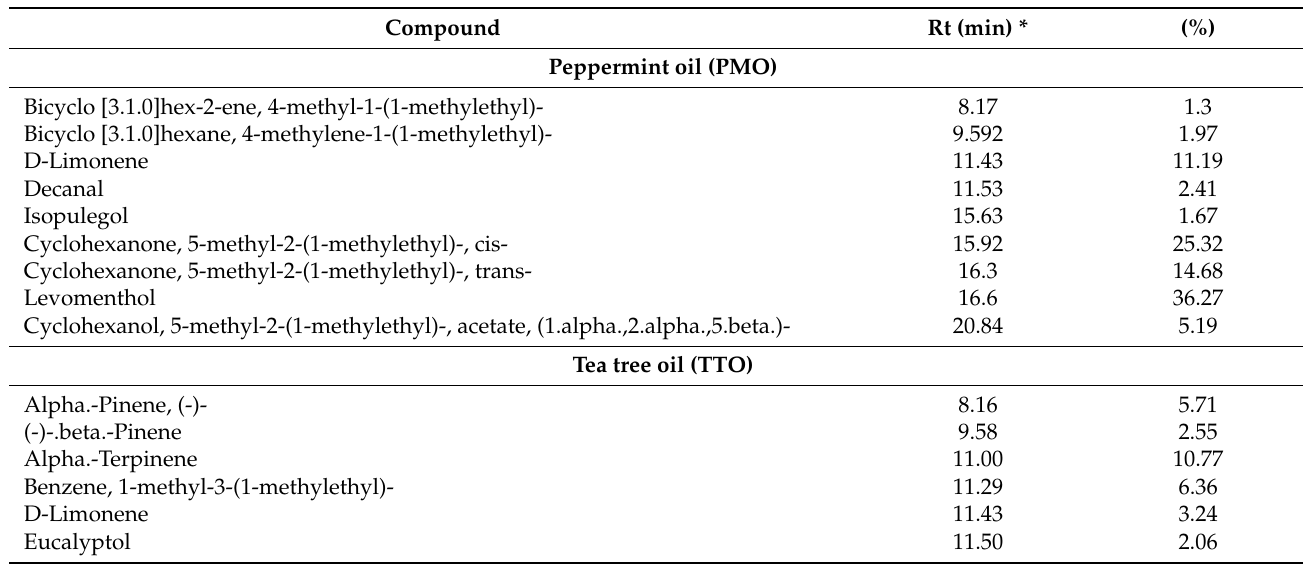
Table 1. Identified volatile compounds of peppermint and tea tree essential oils.